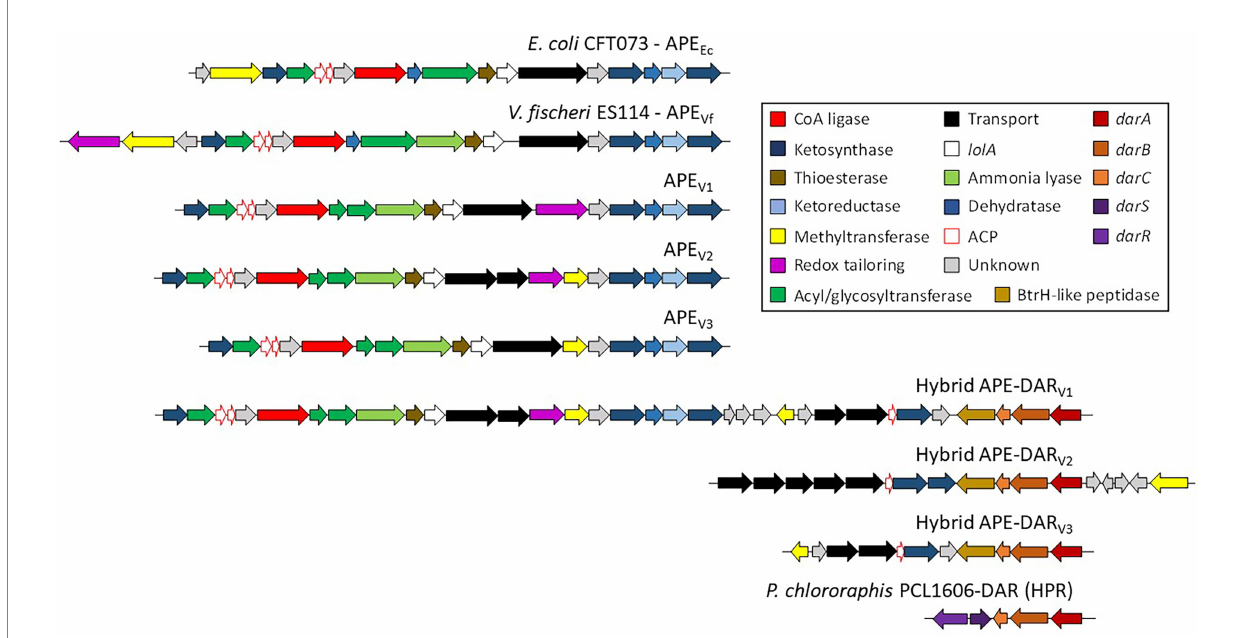
FIGURE 3 Known and proposed gene clusters involved in the biosynthesis of APE, DAR and Hybrid APE-DAR. All genes are scaled to the depicted size.